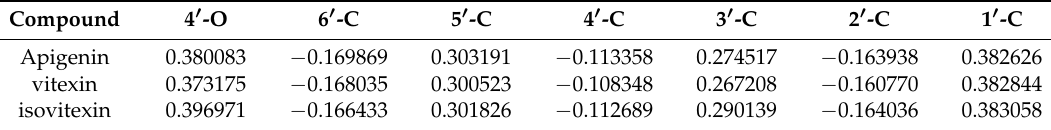
Table 3. The C-ring’s spin density of apigenin, vitexin and isovitexin.